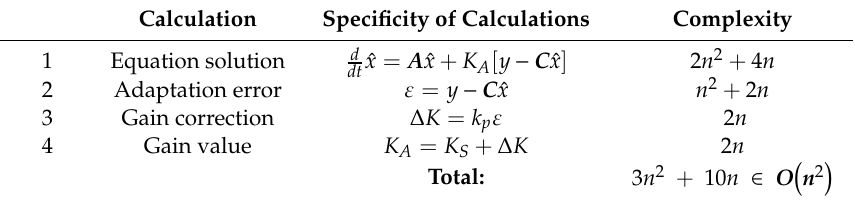
Table 1. Computational complexity of the adaptive algorithm.